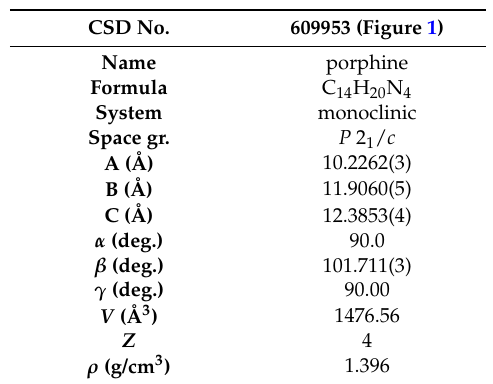
Table 1. Crystallographic Properties of Porphine [9].